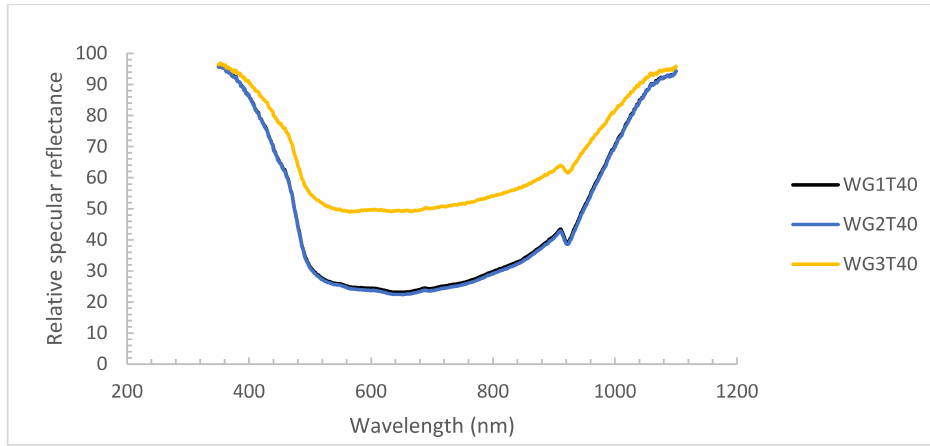
Figure 6. Specular light reflectance of the first set of specimens fired at 1000 ◦ C during 40 min.